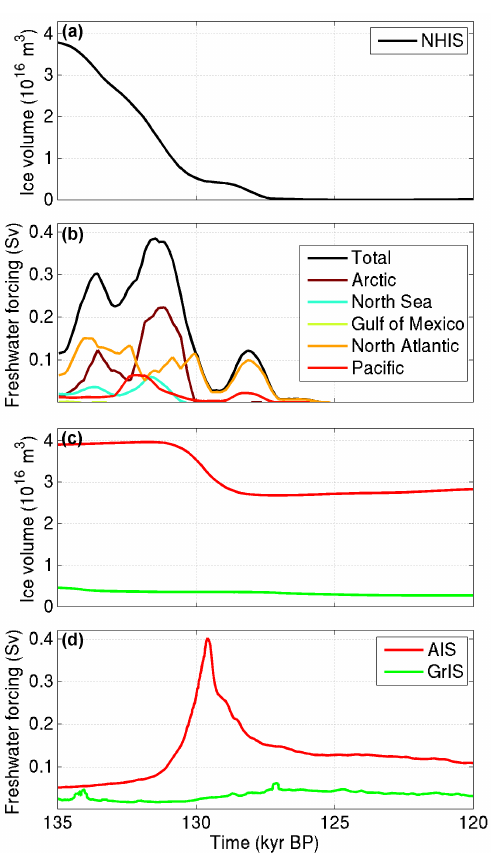
Figure 3. Reconstructed ice volume (a, c) and freshwater forcing (b, d) from the NH ice sheets (a, b) and from the GrIS and AIS (c, d) . See Goelzer et al. (2012b) for definition of oceanic basins in (b) .